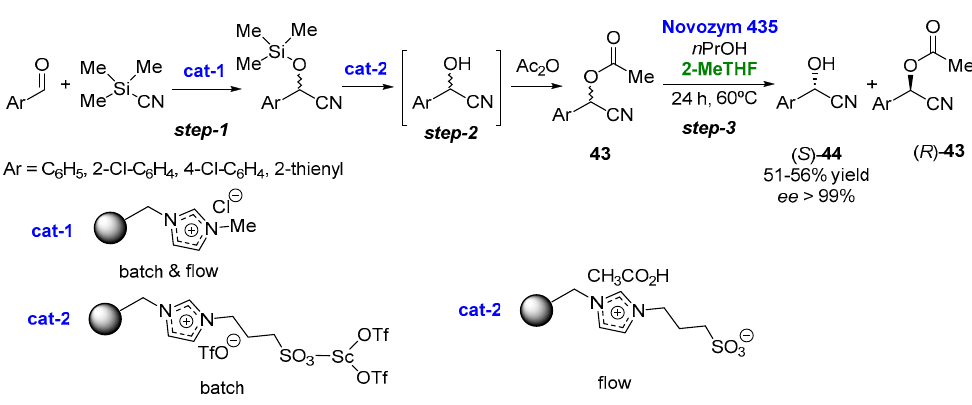
Figure 22. Chemoenzymatic cascade leading to pure chiral cyanohydrins.